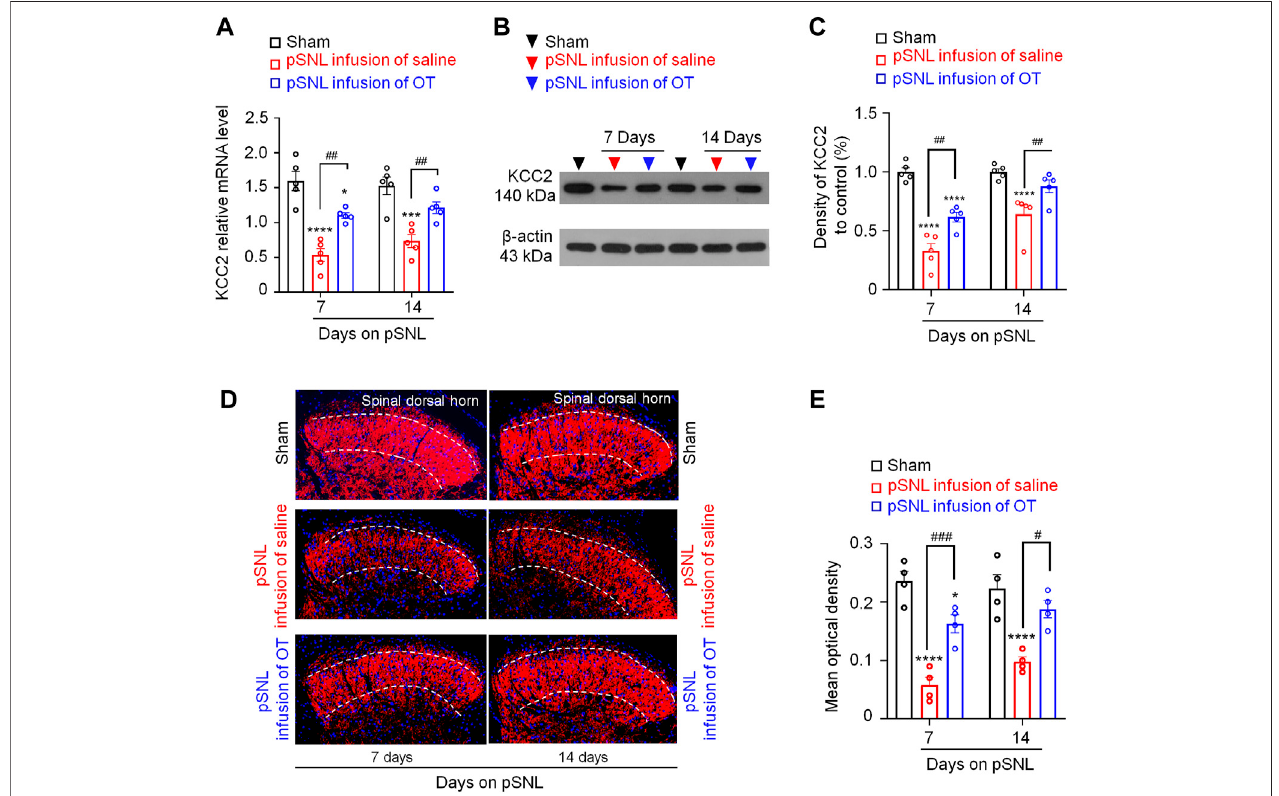
FIGURE5| Three-daycontinuousintrathecalOTinfusionincreasedKCC2expressioninthespinaldorsalhorninpSNLmice. (A) ContinuousintrathecalOTinfusion increased spinal KCC2 mRNA on days 7 and 14 after pSNL. (B,C) Continuous intrathecal OT infusion upregulated spinal KCC2 protein levels on days 7 and 14 after pSNL. (B) Representative western blots of KCC2 and the loading control ( β -actin) are presented for each group. (D) Representative image shows the staining of KCC2 (red) in naïve mice and in pSNL mice treated with saline or OT. DAPI was used to stain the cell nuclei (blue) (E) The intensity of KCC2 staining. One-way repeated measuresANOVAwasusedtoanalysedifferencesacrossdayswithineachgroup.SimpleeffectsANOVAwasusedtocon fi rmdifferencesbetweengroupsateachtime point. Data are expressed as mean ± SEM. # p < 0.05, ## p < 0.01, ### p < 0.001 vs. saline; *** p < 0.001, **** p < 0.0001 vs. sham.